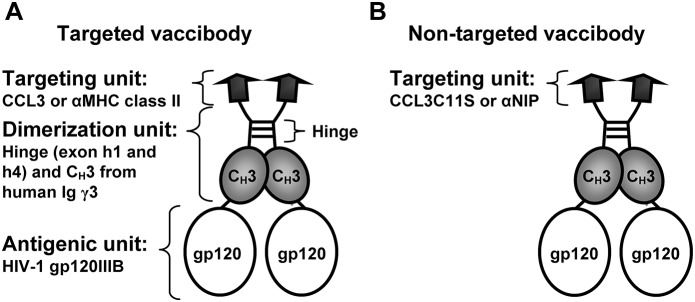
Schematic drawing of gp120-containing vaccibodies.(A) The vaccibody format is a homodimer which consists of three functional units: the targeting, the dimerization, and the antigenic unit. The chemokine CCL3 and the Ig variable regions specific for MHC class II (denoted αMHCII) were utilized to target APCs. The variable regions were assembled in a single chain variable fragment-format (scFv). (B) Vaccibodies without the ability to target APCs, indicated as non-targeted vaccibody, were generated by use of a mutant of CCL3 (CCL3C11S) which does not bind receptor and variable regions specific for the hapten NIP (denoted αNIP). These variable regions were also inserted into the scFv-format.